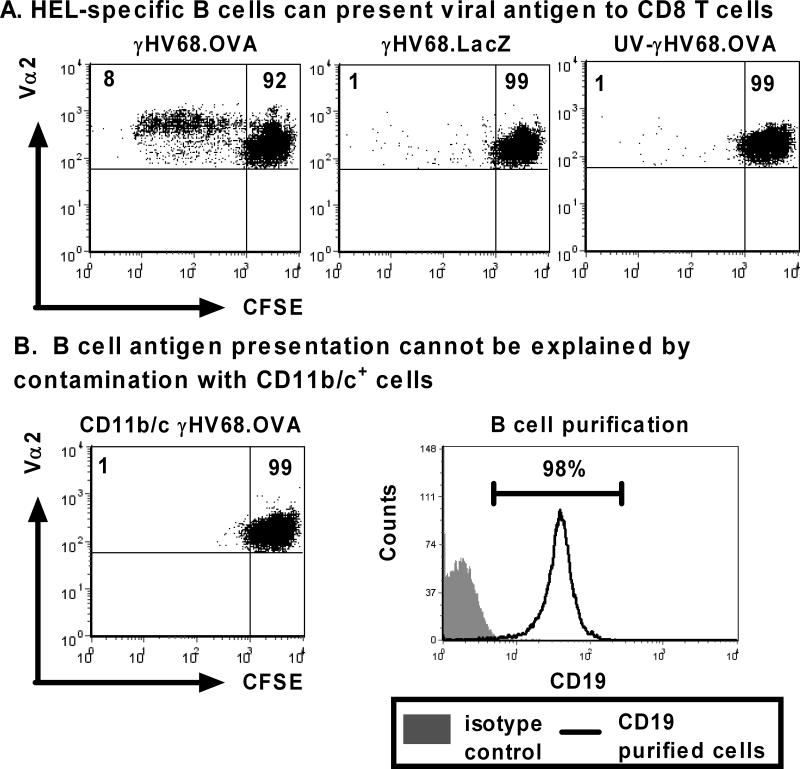
Virus Non-Specific B Cells Present γHV68-Encoded Ag to CD8 T Cells(A) Antigen presentation by HEL-specific B cells infected with γHV68.OVA, γHV68.LacZ, or UV-inactivated γHV68.OVA. Purified B cells were incubated with CFSE labeled OT1 T cells to determine their ability to present antigen. Antigen presentation was measured by the ability of APCs to induce proliferation in OT1 T cells, as shown by dilution of CFSE after cell division. Shown are representative dot plots from flow cytometry experiments with percentages noted in the quadrants. Plots were gated on TCR Vα2+ cells.(B) Contamination of purified B cells with CD11b/c+ cells cannot account antigen presentation (left panel). Purity of fractionated CD19+ cells (right panel). These data are representative of two to six independent experiments using three to five mice per experiment.